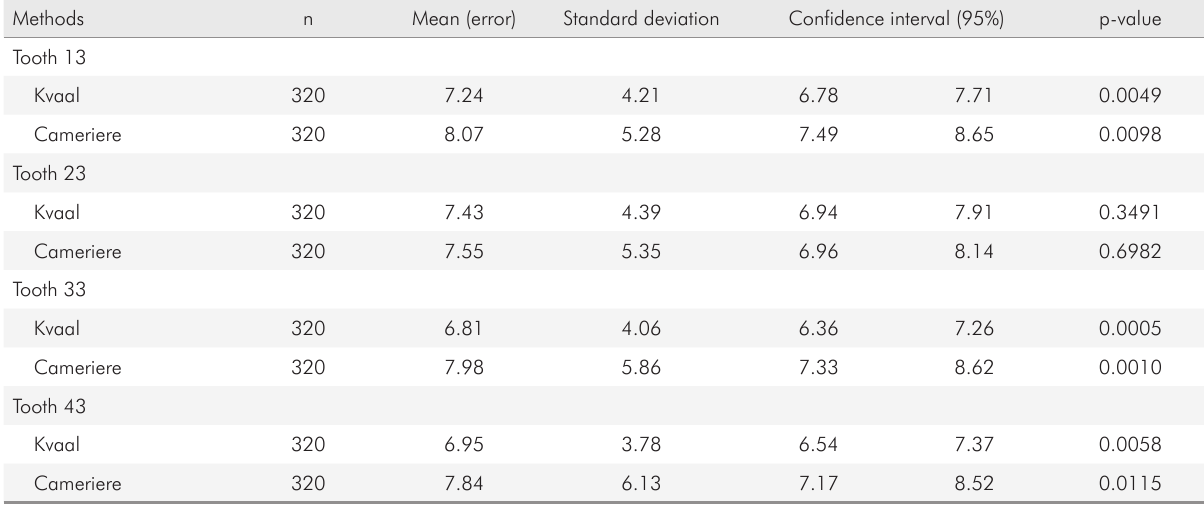
Table 4. Mean error of ages estimated by the Kvaal et al. 9 and Cameriere et al. 4 methods according to the dental unit studied. Methods